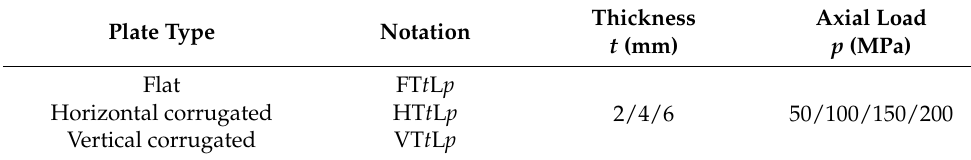
Table 4. Parametric analysis.